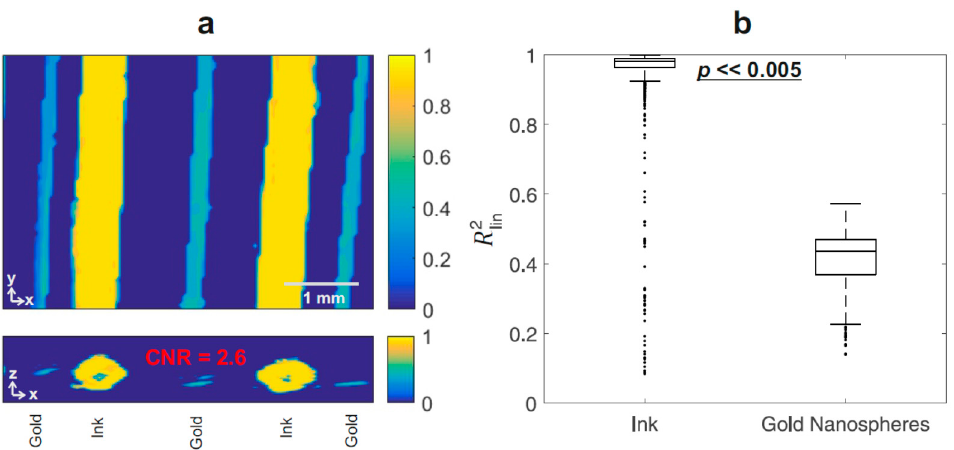
Figure 4. Results of Method I (linear regression). ( a ) xy ‐ and xz ‐ MIPs of the coefficient of determination o f a linear regression, (cid:1844) (cid:3039)(cid:3036)(cid:3041)(cid:2870) ( Equation 1) applied to the PA image intensity as a function of fluence for each voxel of a 3D PA image. The contrast ‐ to ‐ noise ratio (CNR) computed with (cid:1844) (cid:3039)(cid:3036)(cid:3041)(cid:2870) is also reported. ( b ) Boxplot of (cid:1844) (cid:3039)(cid:3036)(cid:3041)(cid:2870) for the tubes filled with gold nanospheres compared with those filled with India ink.